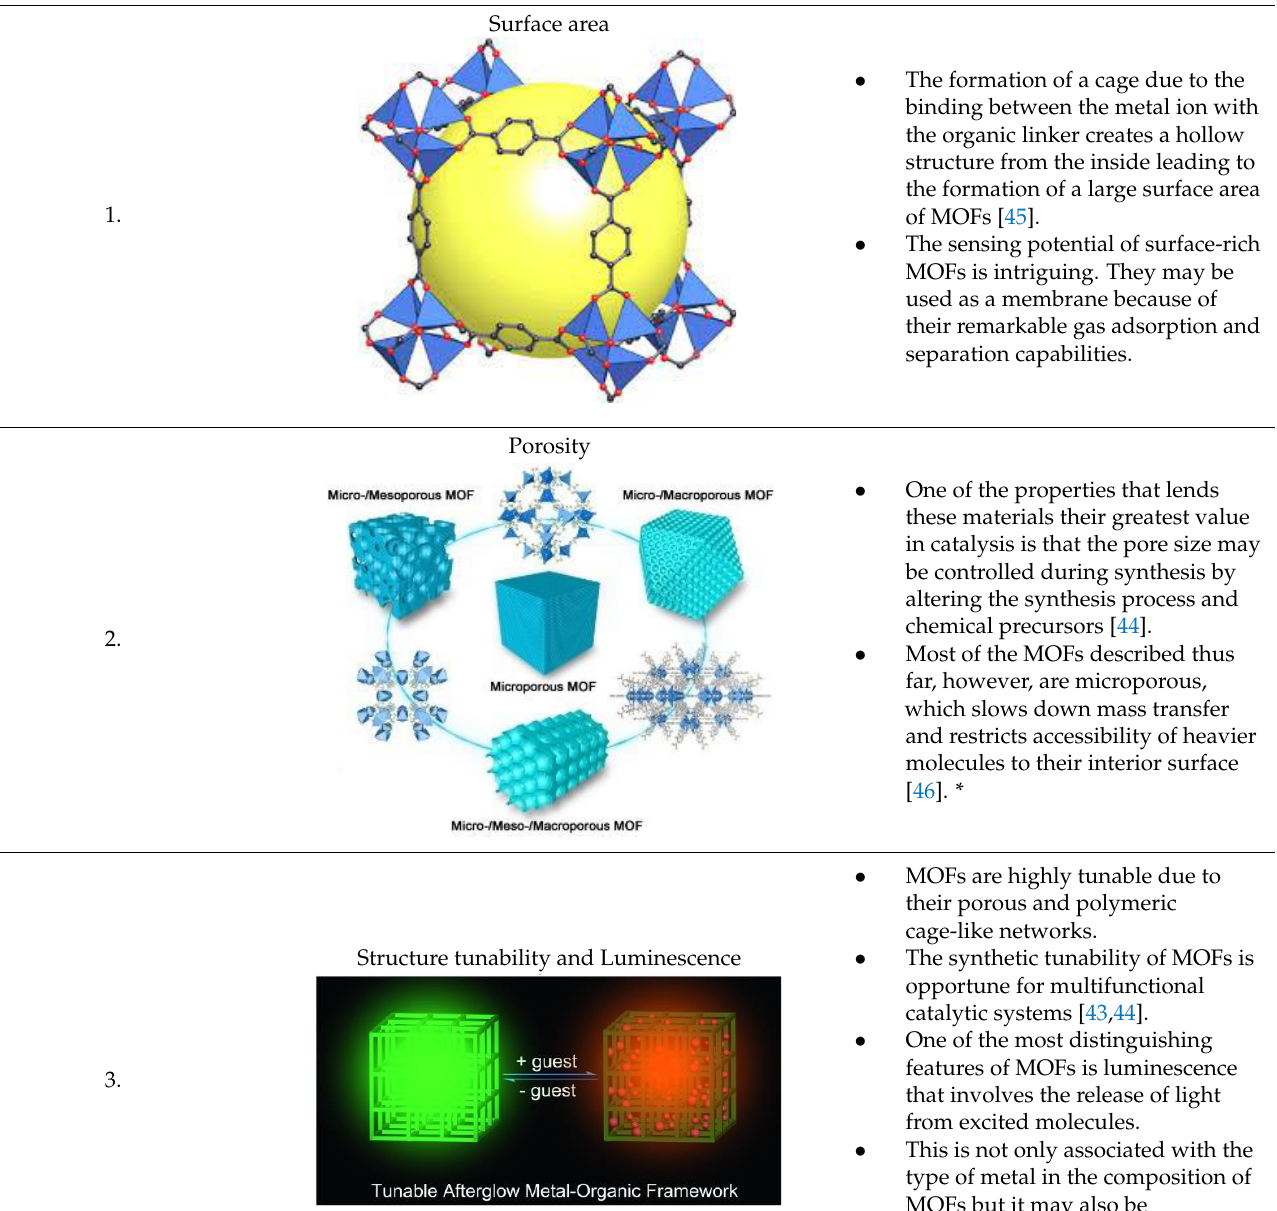
Figure 3. Depicting physicochemical properties of MOFs. Table 1. Physico-chemical properties of MOFs. * Reproduced from references with permission.